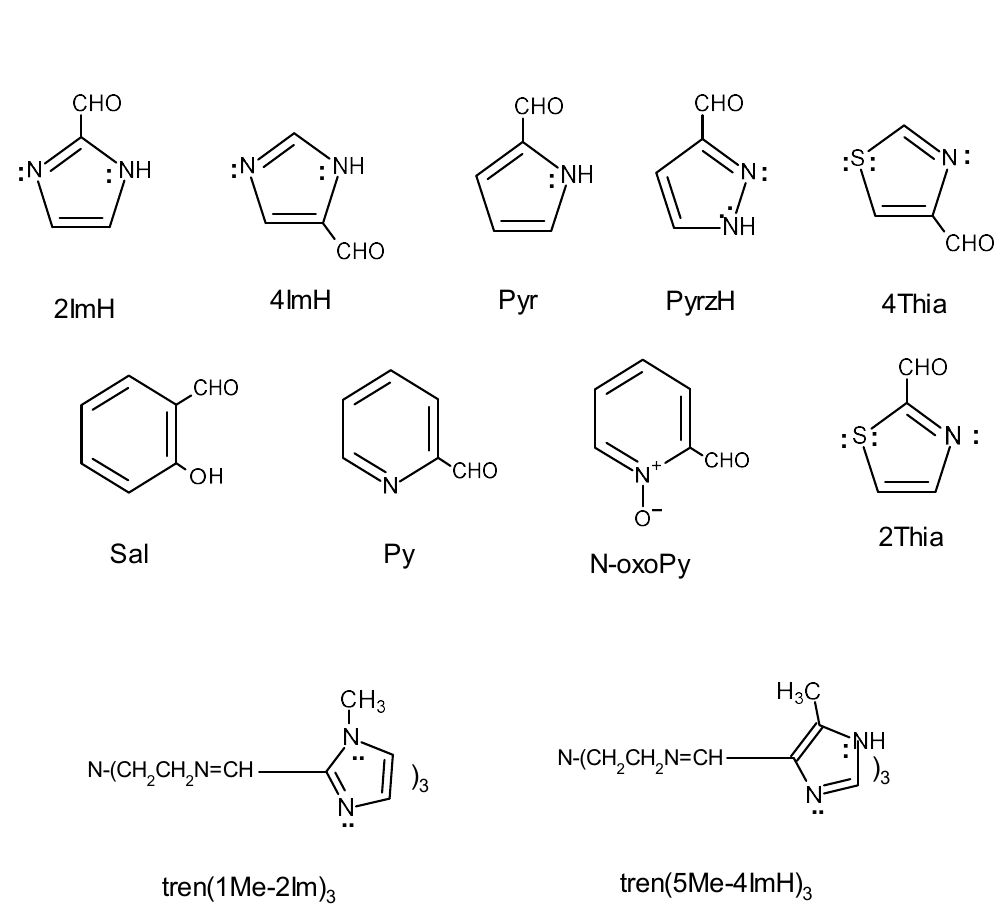
Figure 1. Line drawings of tripodal amines (top), aldehydes (middle), and examples of tripodal Schiff base ligands (bottom) with names. A particular tripodal ligand is specified by giving the symbol of the amine, which serves as the backbone, followed by the aldehyde that it reacts with. A line drawing of each of the ligands utilized and its abbreviation are provided as a supplemental file.